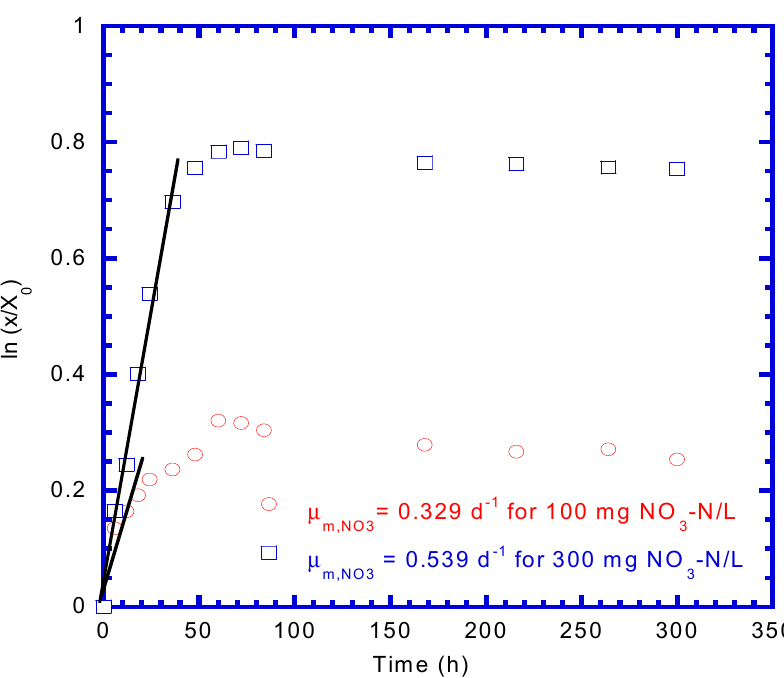
Figure 4. Batch kinetic test to determine maximum specific growth rate of denitrifying biomass at different initial nitrate concentrations of 100 and 300 mg NO 3 -N/L.